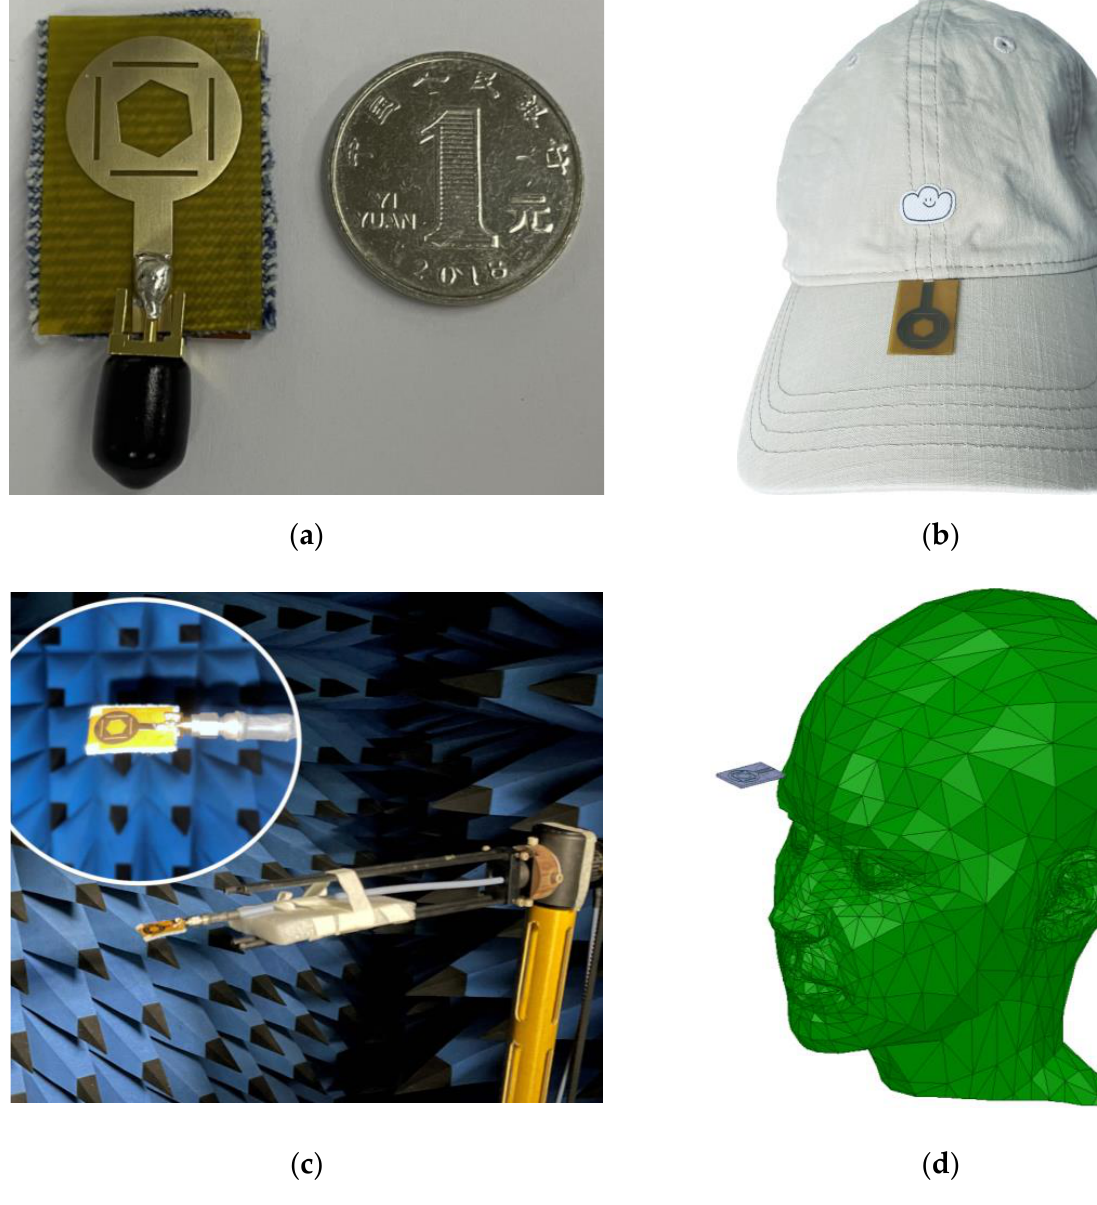
Figure 7. ( a ) Wearable antenna; ( b ) Antenna integrated into a peaked cap; ( c ) radiation pattern measured in free space; ( d ) human head model.